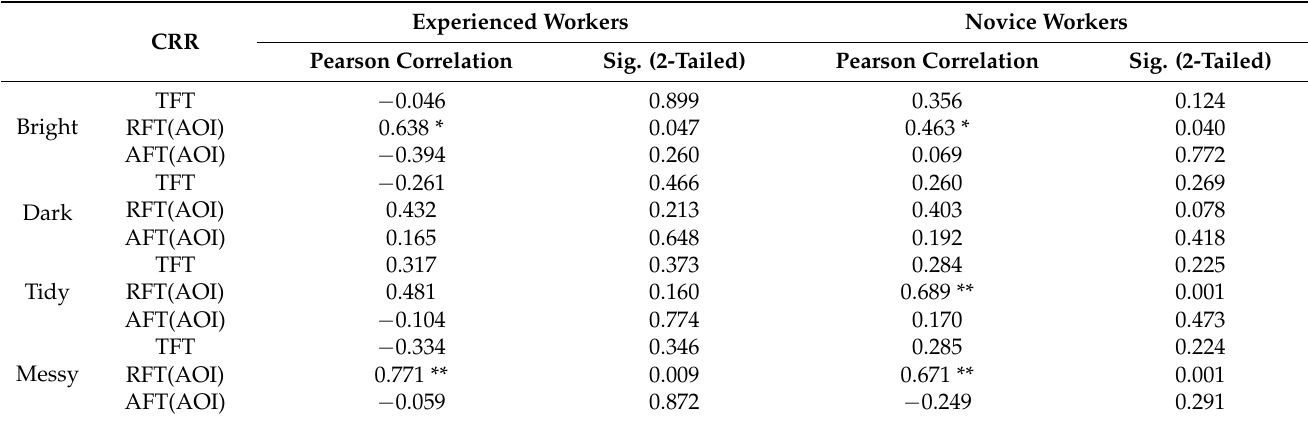
Table 4. Pearson correlation test between CRR and TFT, RFT (AOI), and AFT